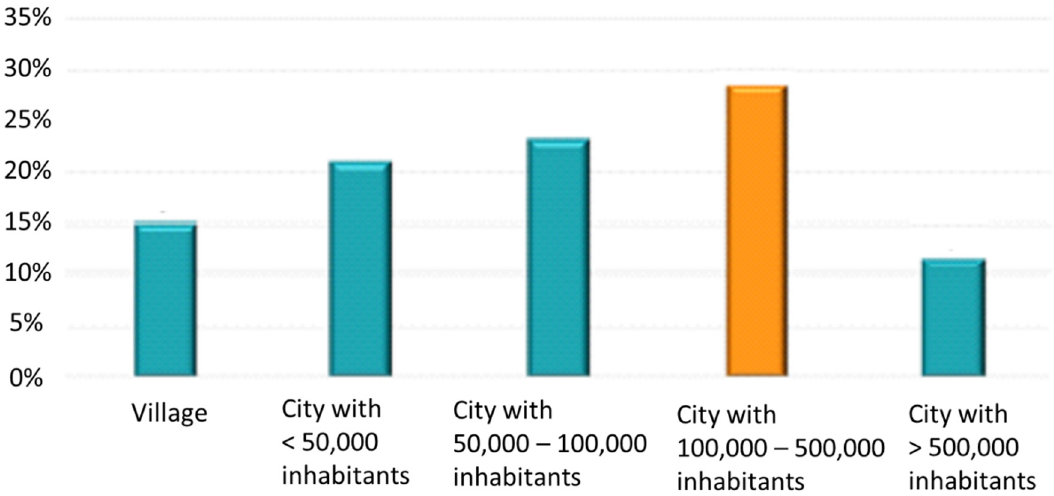
Figure 1. Population distribution according to the place of living.